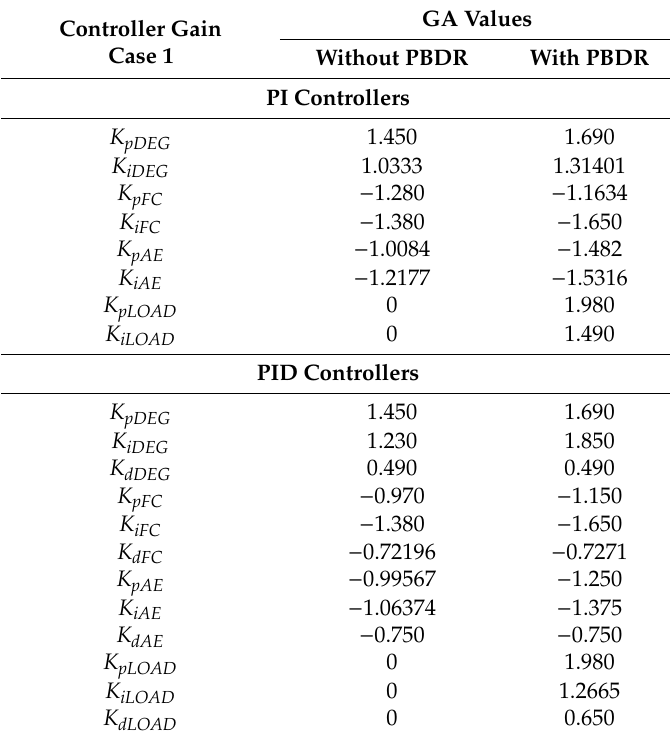
Table 4. PI and PID controller gains for Case